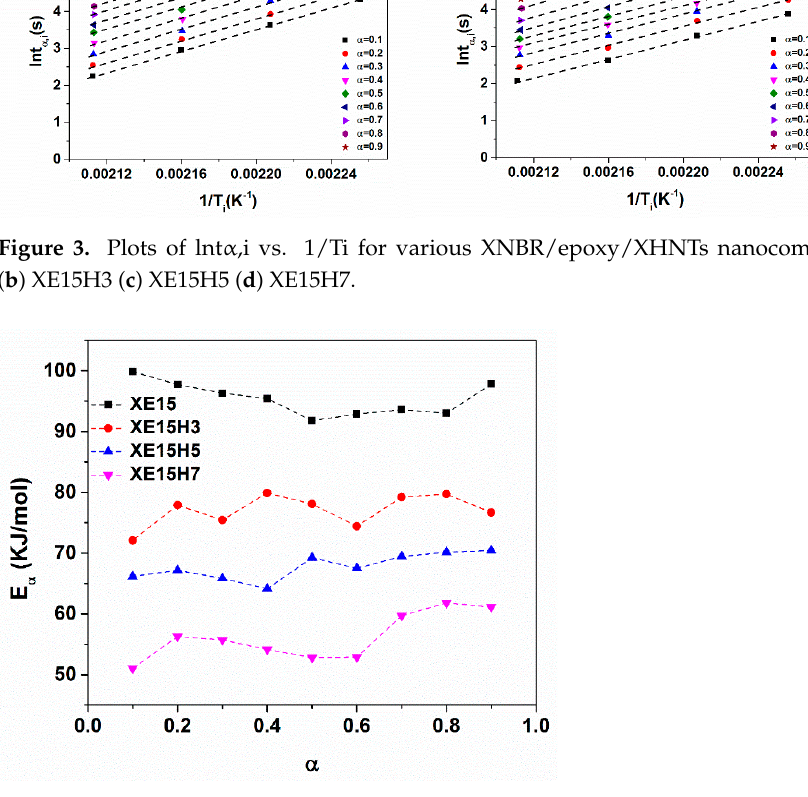
Figure 4. Variation of activation energy at different cure conversion for various XNBR/epoxy/XHNT nanocomposites.